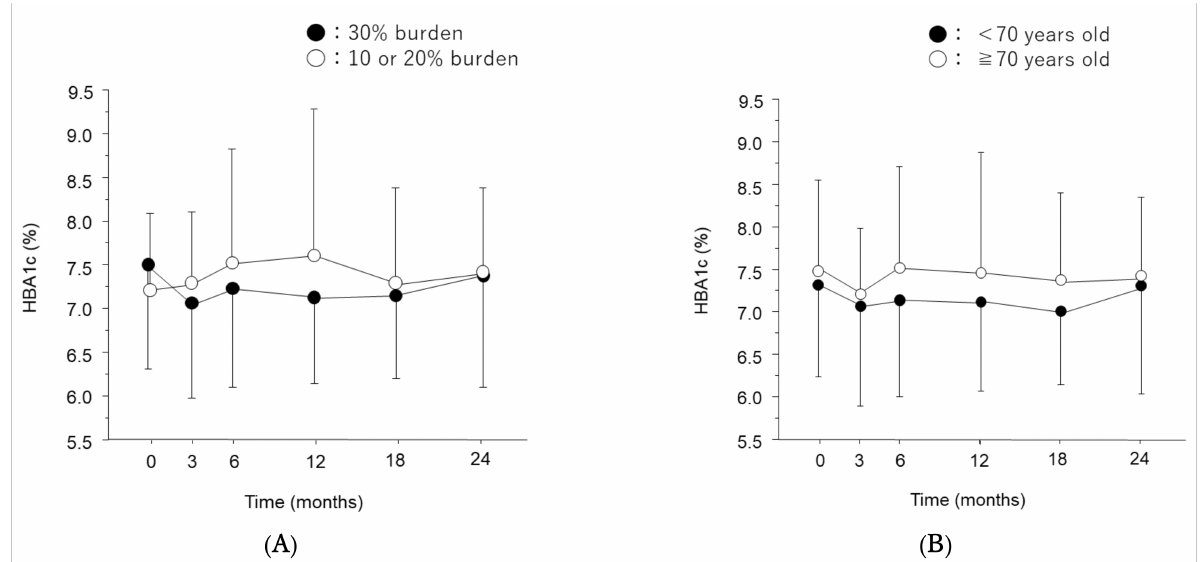
Figure 5. Time course of hemoglobin A1c (HbA1c) after initiation of anti-vascular endothelial growth factor (VEGF) therapy. HbA1c levels were measured in patients with a 30% copayment ( • ), and 10% or 20% copayment ( ) ( A ); and in patients aged ≥ 70 years ( • ), and <70 years ( (cid:35) represented as mean ± standard deviation